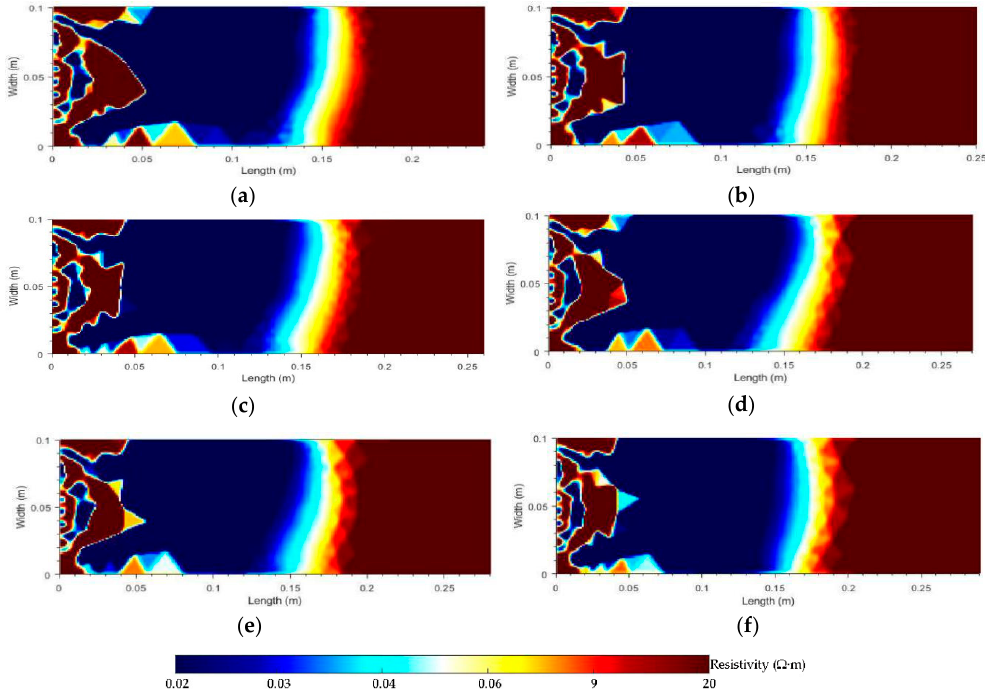
Figure 10. Inversion results of virtual grounding electrode at different distances when L = 0.15 m, I 0 = 1 mA and I 1 = 2 mA. ( a ) Is the inversion result when D = 0.25 m; ( b ) is the inversion result when D = 0.26 m; ( c ) is the inversion result when D = 0.27 m; ( d ) is the inversion result when D = 0.28 m; ( e ) is the inversion result when D = 0.29 m; ( f ) is the inversion result when D = 0.30 m.